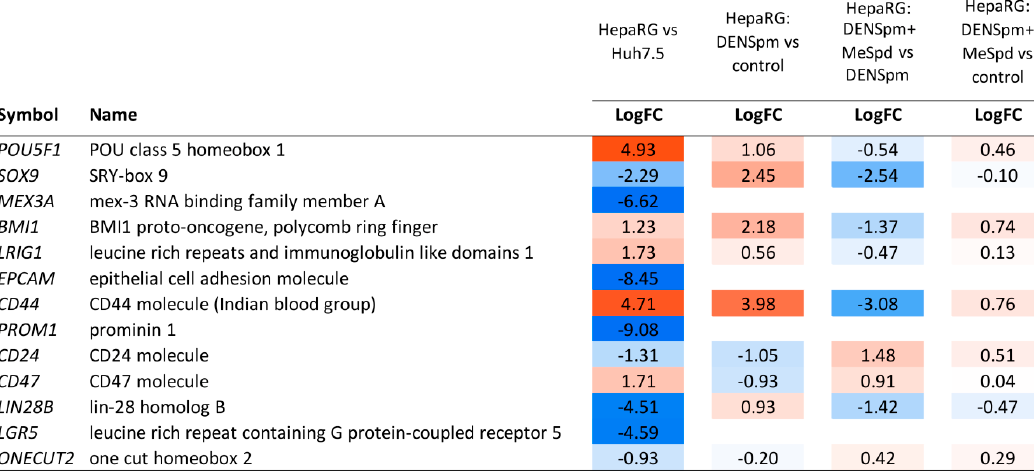
Figure 9. Expression of stem cell marker genes in four comparisons: (a) HepaRG versus Huh7.5 cells (HepaRG vs. Huh7.5); (b) DENSpm-treated HepaRG vs. non-treated HepaRG cells (HepaRG: DENSpm vs. control); (c) DENSpm+MeSpd-treated HepaRG cells vs. DENSpm-treated HepaRG cells (HepaRG: DENSpm+MeSpd vs. DENSpm); (d) DENSpm+MeSpd-treated HepaRG cells vs. non-treated HepaRG cells (HepaRG: DENSpm+MeSpd vs. control). LogFC—binary logarithm of expression level fold change.